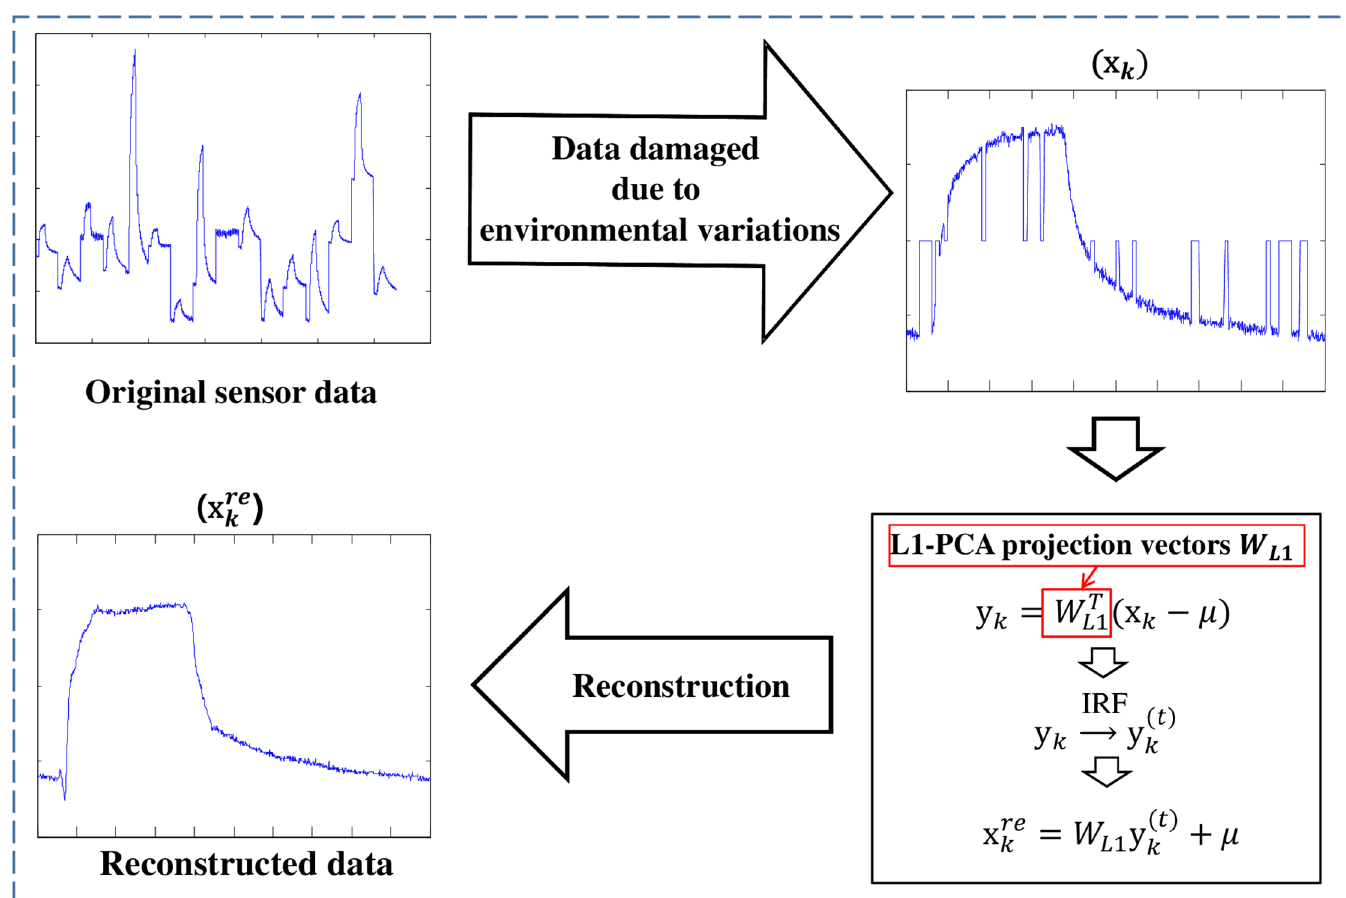
Fig 4. Overall procedure of the proposed data reconstruction